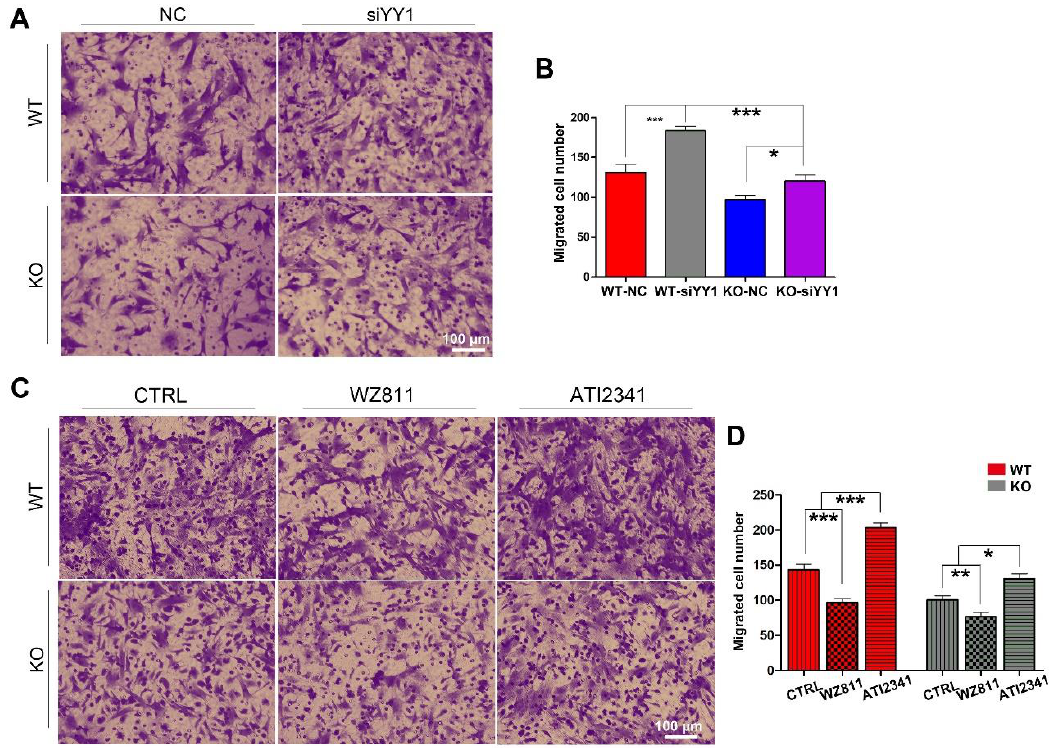
Figure 4. Transwell assay and quantifications show the effects of siYY1 transfection, WZ811, and ATI2341 treatment on the macrophage migration. ( A ) Transwell assay and ( B ) quantitative analysis showing the number of migrated macrophages from KO–siYY1 group is significantly more than the KO–NC group. ( C ) Transwell assay and ( D ) quantitative analysis showing the number of migrated macrophages from the KO–ATI2341 group can be reversed compared to KO–CTRL group. Data are expressed as the mean ± SEM ( n = 3 for each group, N.S p ≥ 0.05, * p < 0.05, ** p < 0.01, *** p < 0.001).